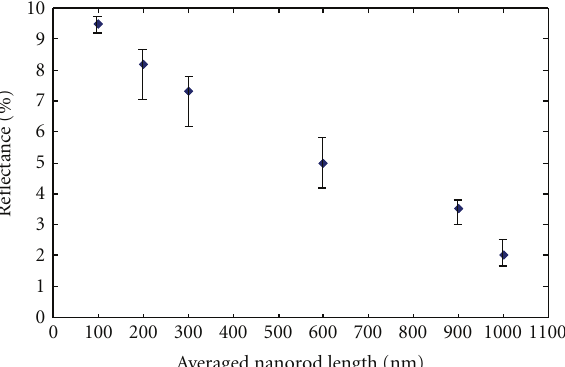
Figure 3: The optical reflection of 6 (cid:2)(cid:2) mc-BSWs with di ff erent nanorod lengths. The average length on BSWs distributes from 100 nm to 1 μ m. The reflection is approximately inversely proportional to the average nanorod length. The reflection is about 9.5% for BSW decorated with 100 nm-thick nanorods and suppressed to 2% for BSW with 1 μ m-thick nanorods.